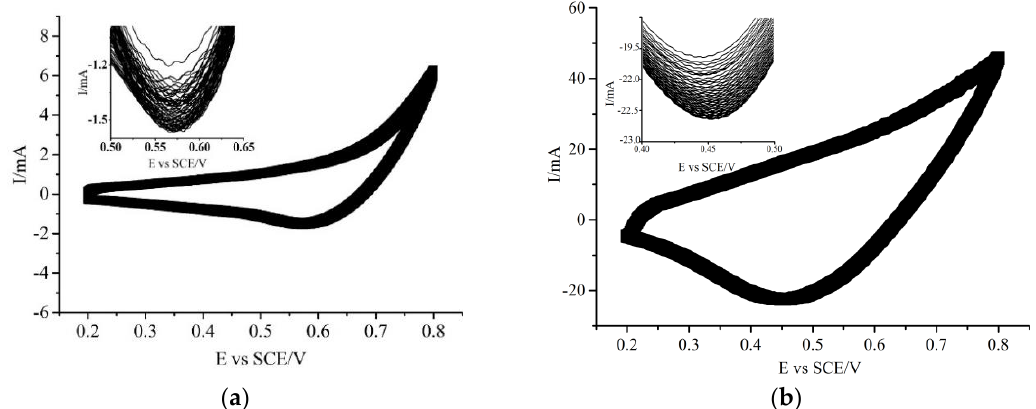
Figure 4. One hundred consecutive CV recorded at the CuNWE ( a ) and CuO/CuNWE ( b ) in a 0.075 M NaOH solution at a scan rate of 0.05 V s −1 .